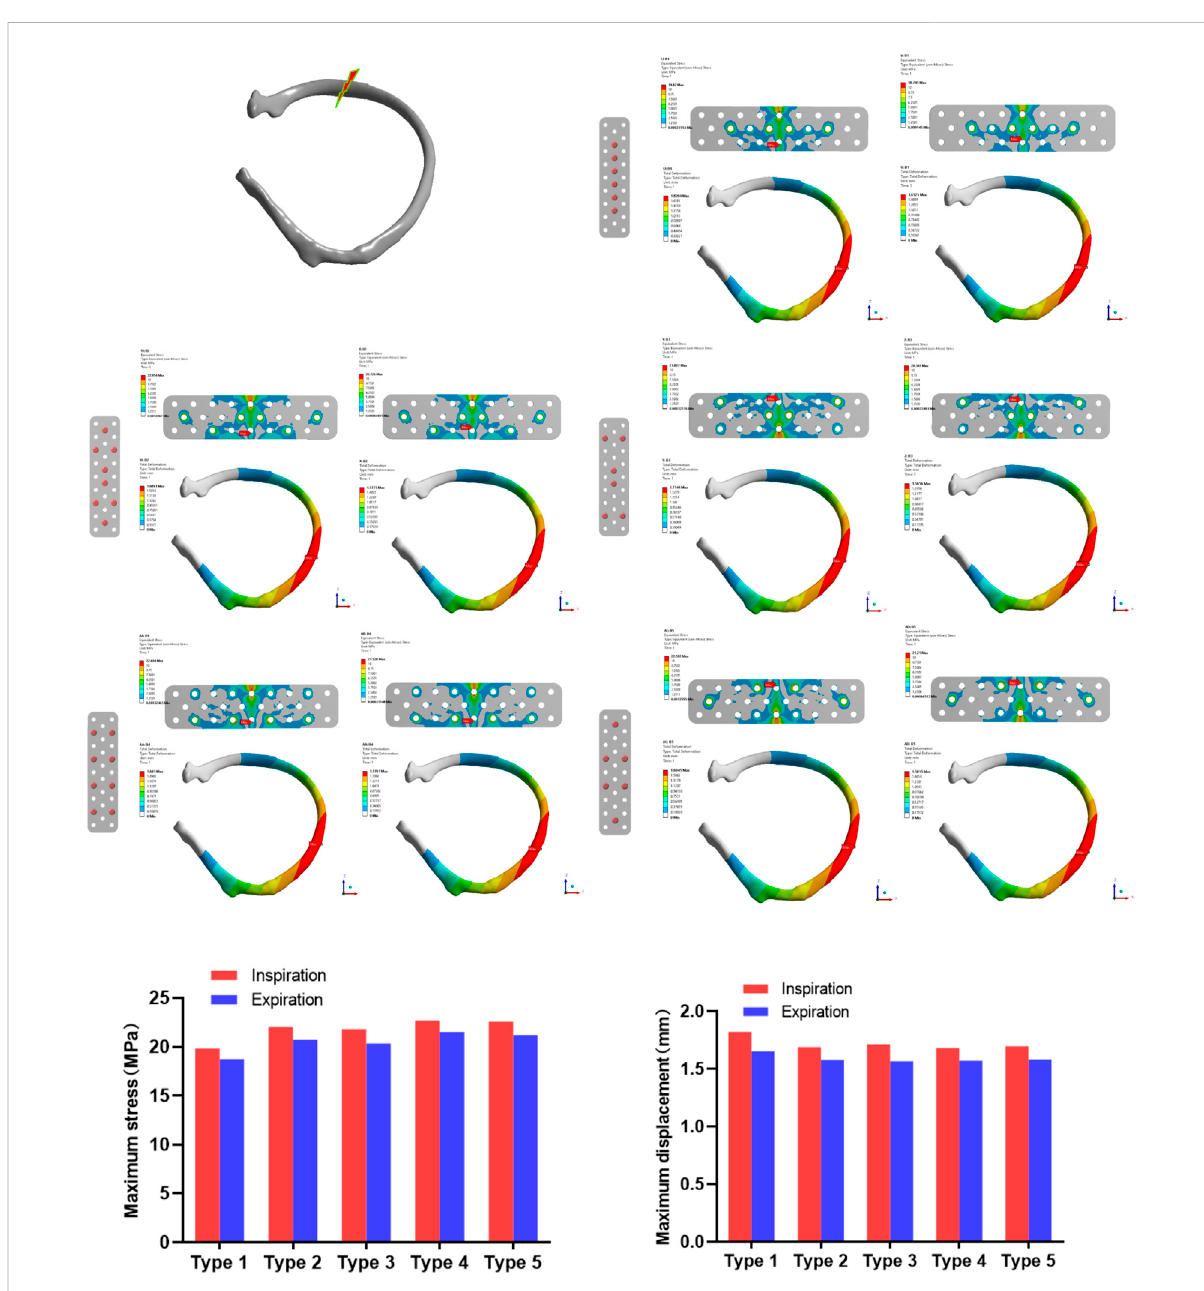
FIGURE 5 The maximum stress and displacement during inhalation and exhalation of the posterior rib fracture after the fi xation with the absorbable plate and screws.